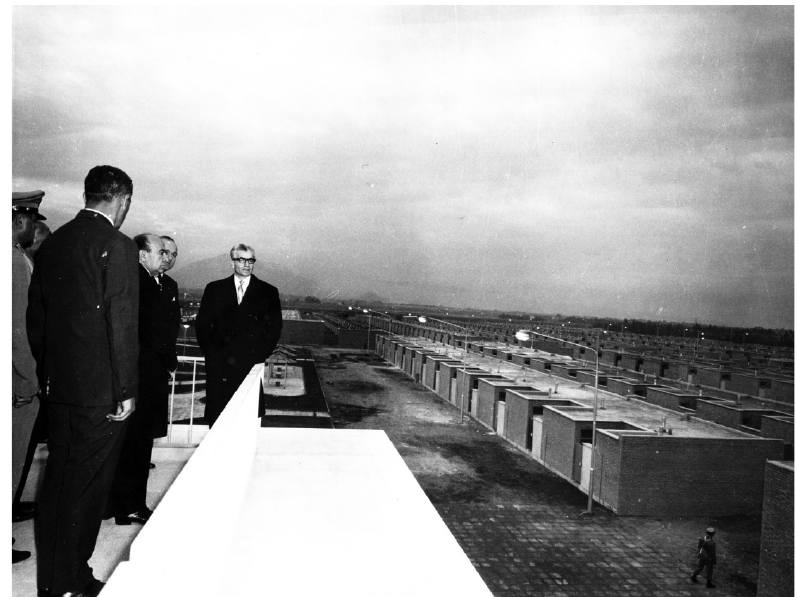
Figure 9. Kuy-e Nohom-e Aban, mass housing project in Tehran, 1962. Source: IICHS (n.d.). was the absolute priority. The design of the housing